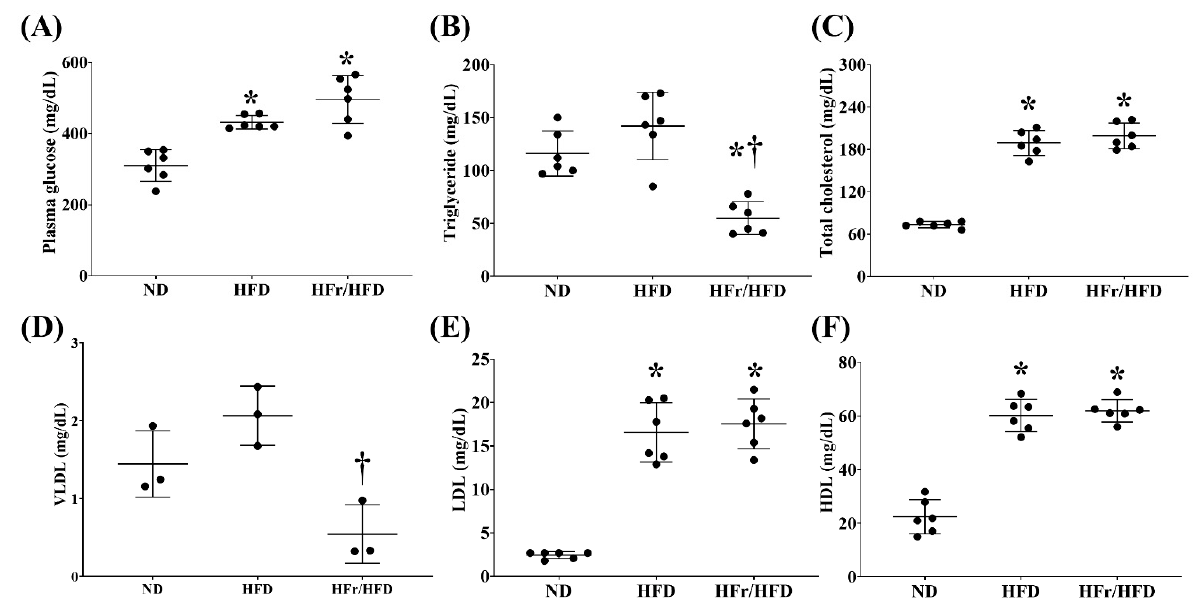
Figure 2. Plasma concentration of ( A ) glucose, ( B ) triglyceride, ( C ) total cholesterol, ( D ) very low- density lipoprotein (VLDL), ( E ) low-density lipoprotein (LDL), and ( F ) high-density lipoprotein (HDL). Glucose, triglyceride, total cholesterol, LDL, and HDL data were obtained from 6 mice in each group and VLDL data were obtained from 3 mice in each group. Data were presented as mean ± standard deviation. ND: normal diet group. HFD: high-fat diet group. HFr/HFD: high-fat diet plus 30% fructose in drinking water group. * p < 0.05, versus the ND group; † p < 0.05, the HFr/HFD group versus the HFD group.